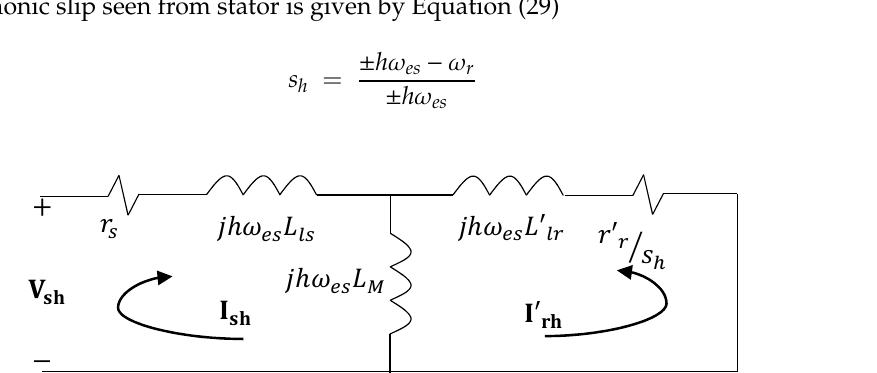
Figure 5. Harmonic equivalent circuit of the induction generator in steady-state seen from stator.